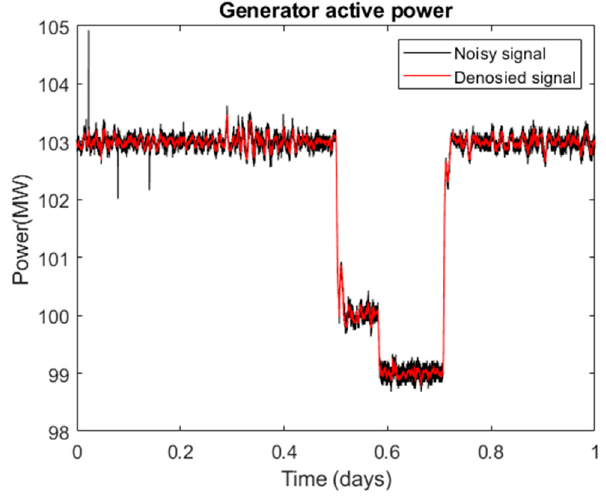
Figure 7. The noisy and denoised sensor signal showing the effectiveness of the wavelet denoising.